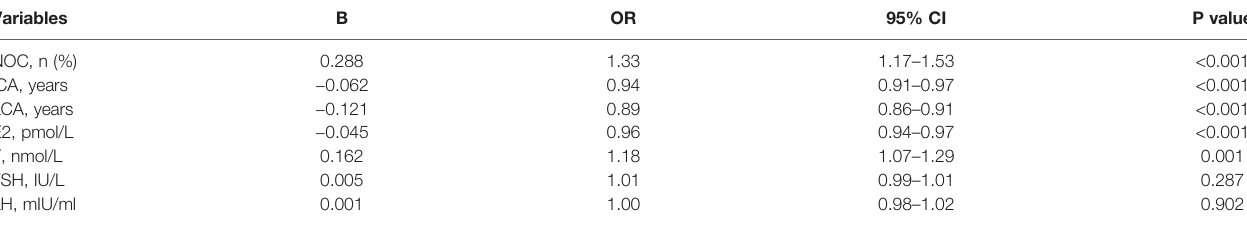
Fertility status and sex hormone associated with women aged 80 – 99 years in the multivariate logistic regression analysis, when centenarian women were considered as reference, after adjusting for ethnicity, education, smoking, drinking, meal times, BI, EQ-5D, BMI, SBP, DBP, TC, TG, HDL-C, LDL-C, and Glu levels. OR, odds ratio; CI, con fi dential interval; NOC, number of children; ICA, initial childbearing age; LCA, last childbearing age; E2, estradiol; T, testosterone; FSH, follicle-stimulating hormone; LH, luteinizing hormone; BI, Barthel Index; EQ-5D, EuroQol 5 Dimensions; BMI, body mass index; SBP, systolic blood pressure; DBP, diastolic blood pressure; TC, total cholesterol; TG, triglyceride; HDL-C, high-density lipoprotein cholesterol; LDL-C, low-density lipoprotein cholesterol; Glu, blood